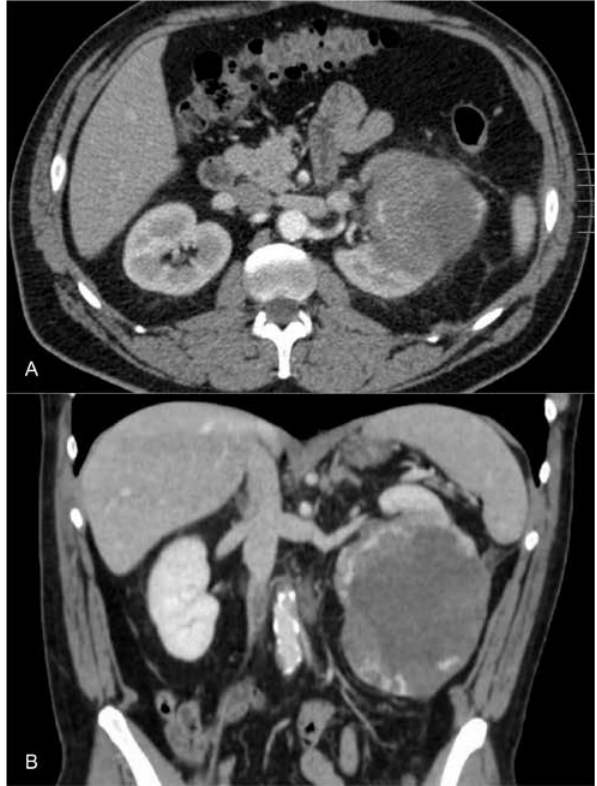
Figure 1: Preoperative computed tomography (ct) scan (a: axial reconstruction; b: coronal reconstruction) showing a mass with a poor vascularization and a collapsed area in the lower pole of the left